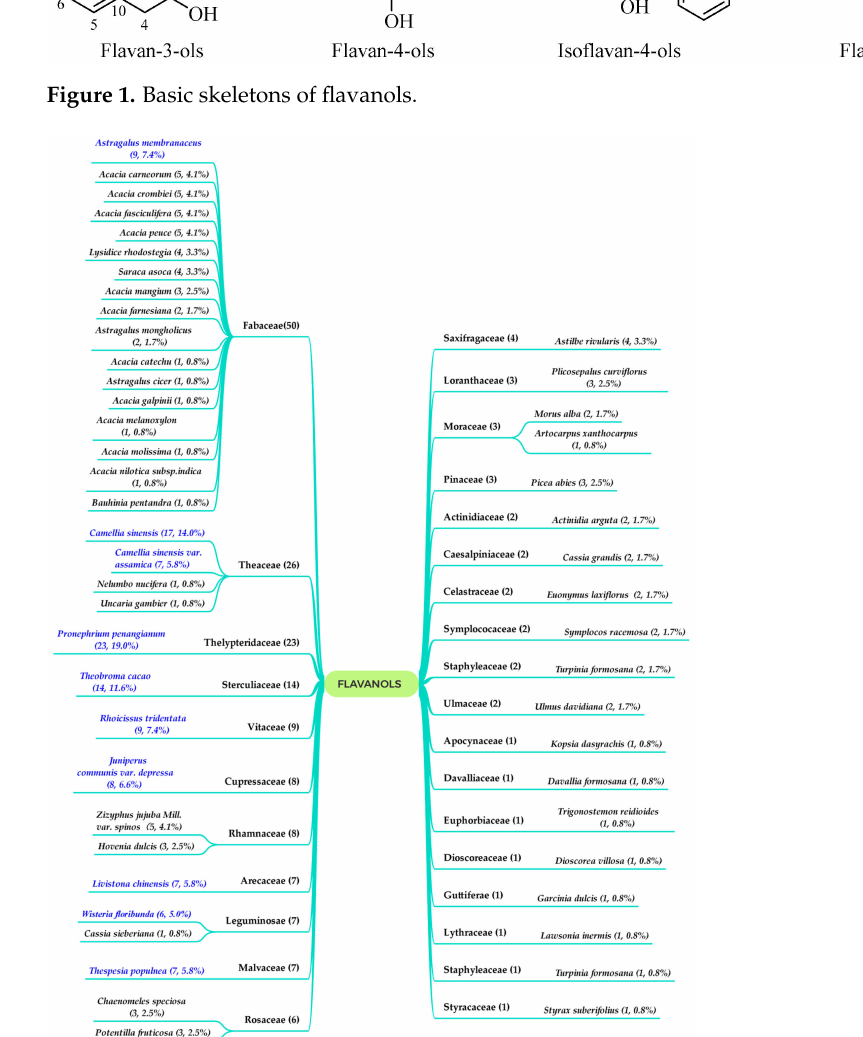
Figure 2. Plant sources of 121 flavanols (Families and species and the corresponding quantity of